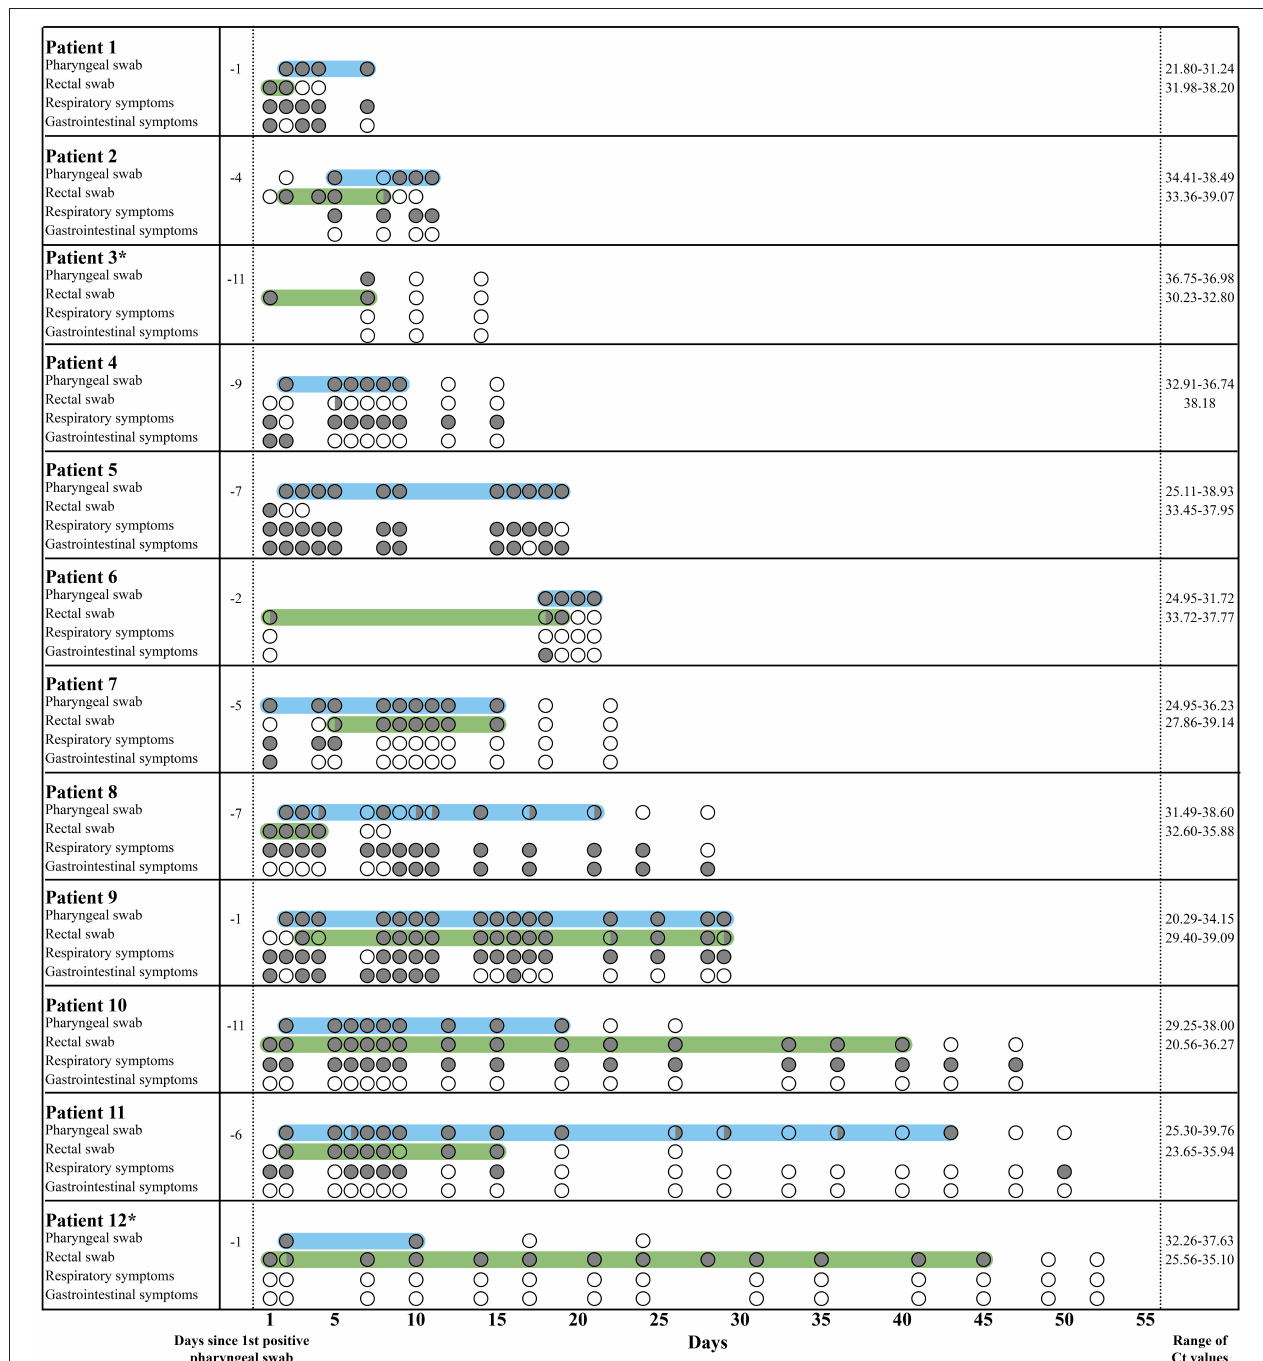
FIGURE 1 | Pharyngeal and rectal swab results from COVID-19 patients followed for more than 6 days. In the rows with pharyngeal and rectal swabs, a gray circle ( ) illustrates a positive result, a transparent circle ( ) illustrates a negative result, and a half-filled circle ( ) illustrates an inconclusive result, where only one of the duplicates was positive. In the rows with respiratory and gastrointestinal symptoms, a gray circle ( ) illustrates the presence of the symptoms, and a transparent circle ( ) illustrates that the symptoms were not experienced. Children are marked by *. The light blue area marks the period where the pharyngeal swabs were positive, while the light green area marks the period where the rectal swabs were positive. Respiratory symptoms include cough, sore throat, sneeze, dyspnea, and colored sputum. Gastrointestinal symptoms include nausea, vomit, stomach ache, and diarrhea.